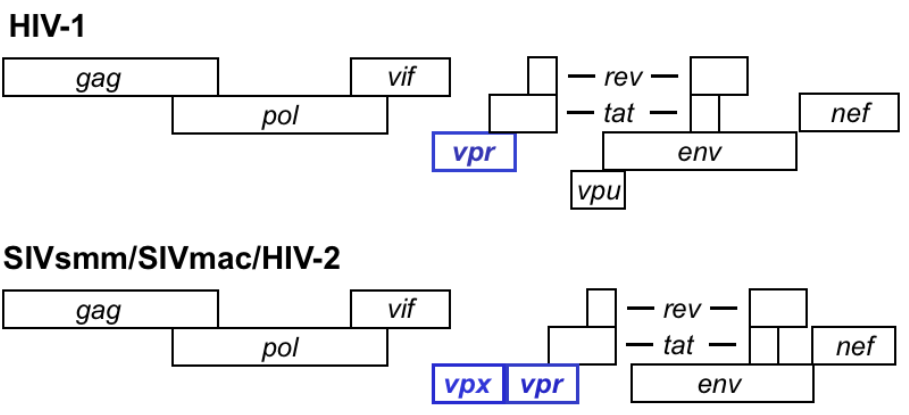
Figure 1. Genetic structure of HIV-1 and